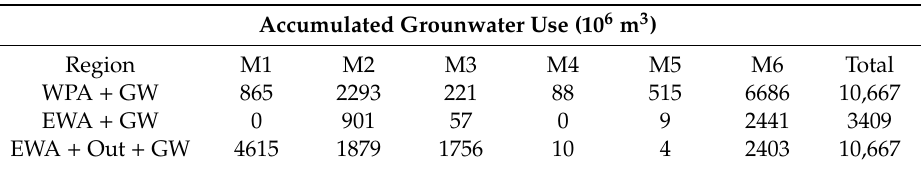
Table 5. Accumulated Groundwater use on the simulations.